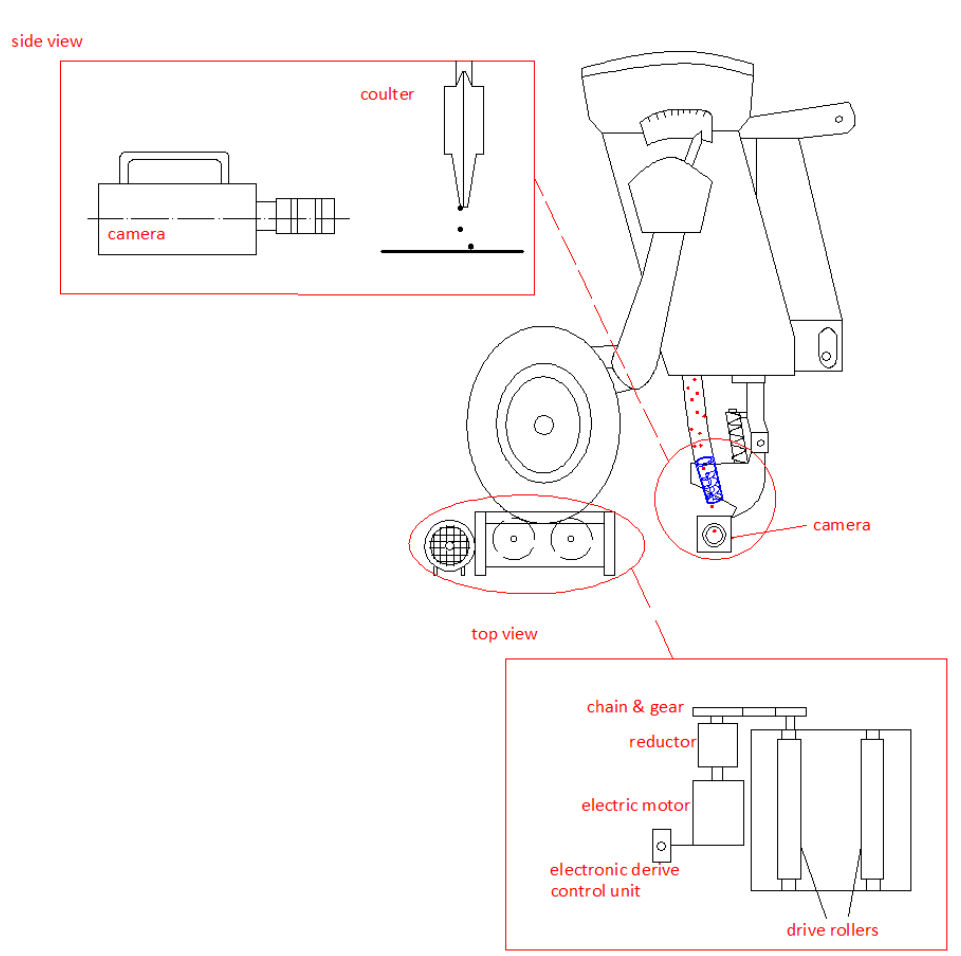
Figure 3. Seed drill used in laboratory and field tests.